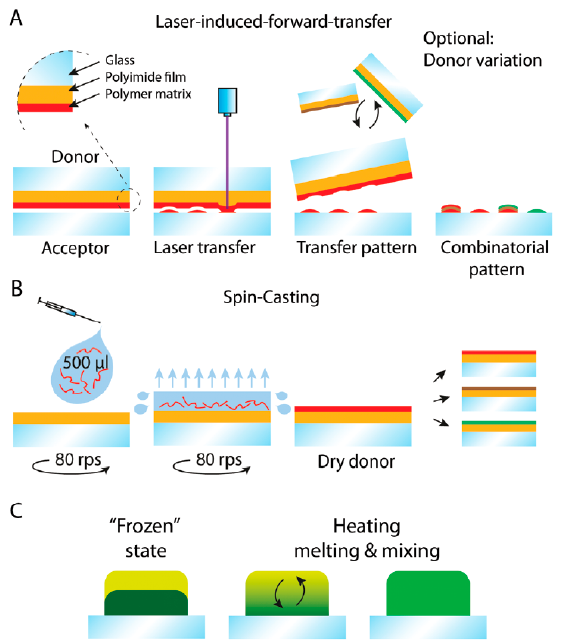
Figure 5. General procedure. ( A ) Microarray generation with laser induced forward transfer; ( B ) Spin-coating of donor slides (glass slide ≈ 1 mm, covered with self-adhesive polyimide foil, ≈ 75 um) with different polymer mixtures (e.g., polystyrene mixed with amino acid building block or fluorescent dye); ( C ) Melting and mixing of transferred polymer spots (not to scale). Reproduced with permission from [55].